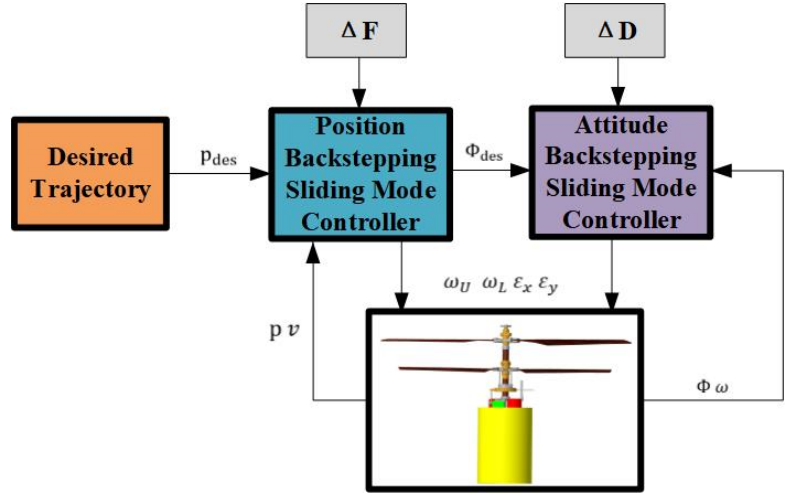
Figure 3. Control block diagram.